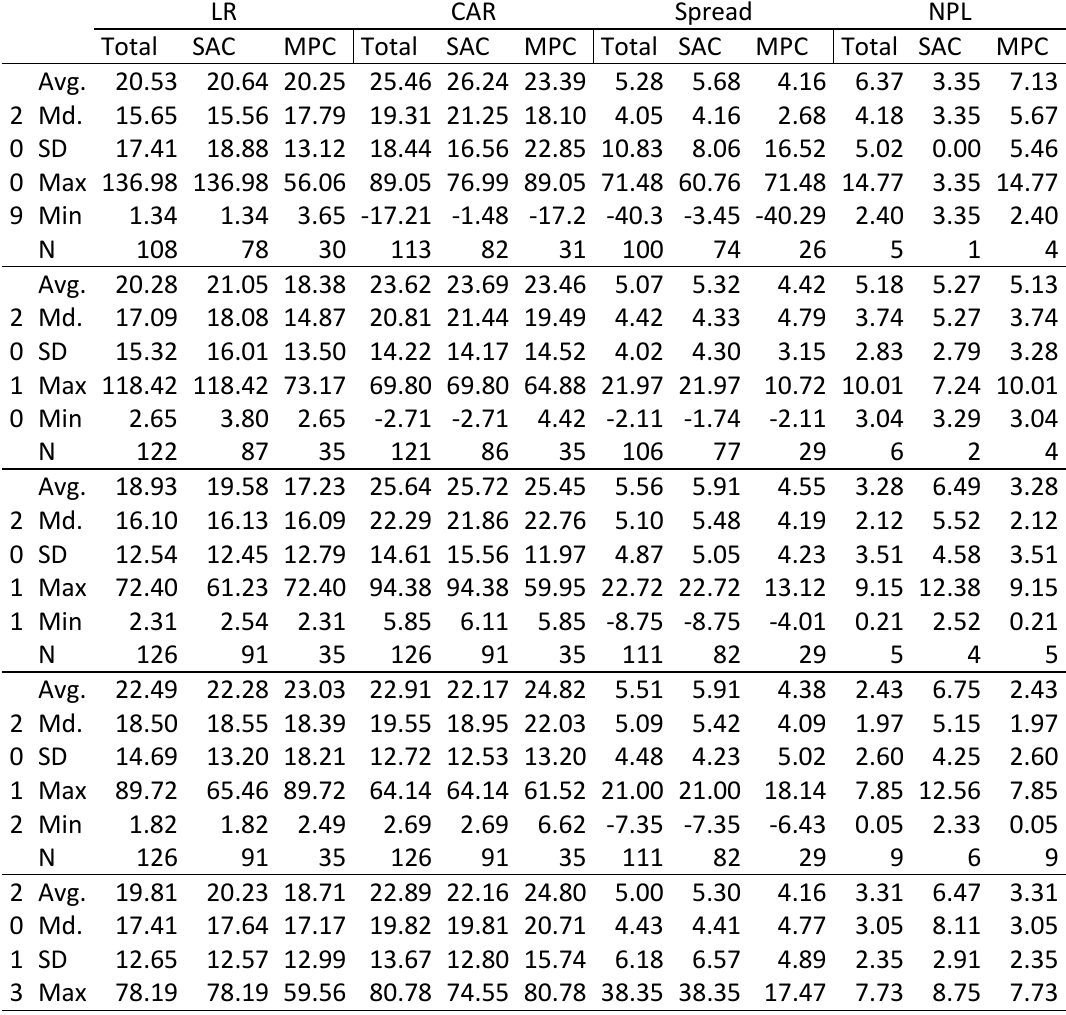
Table 4: Risk Measurement Ratios of 2009-13 (in percent) LR CAR Spread NPL Total SAC MPC